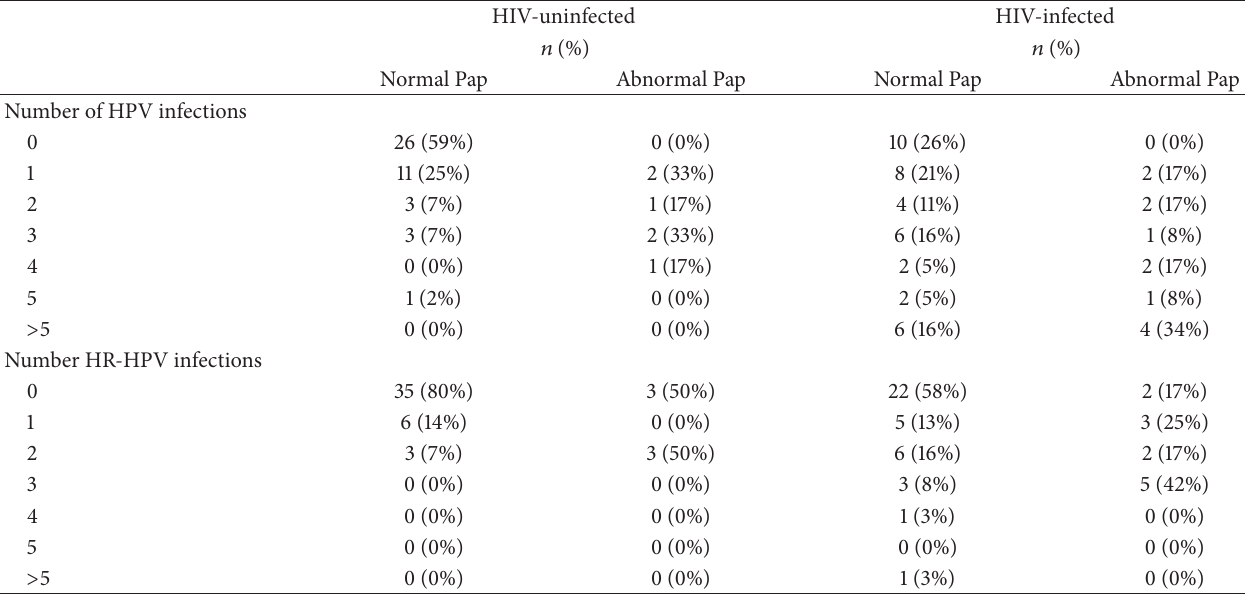
Table 2: HPV infections, Pap test results, and HIV